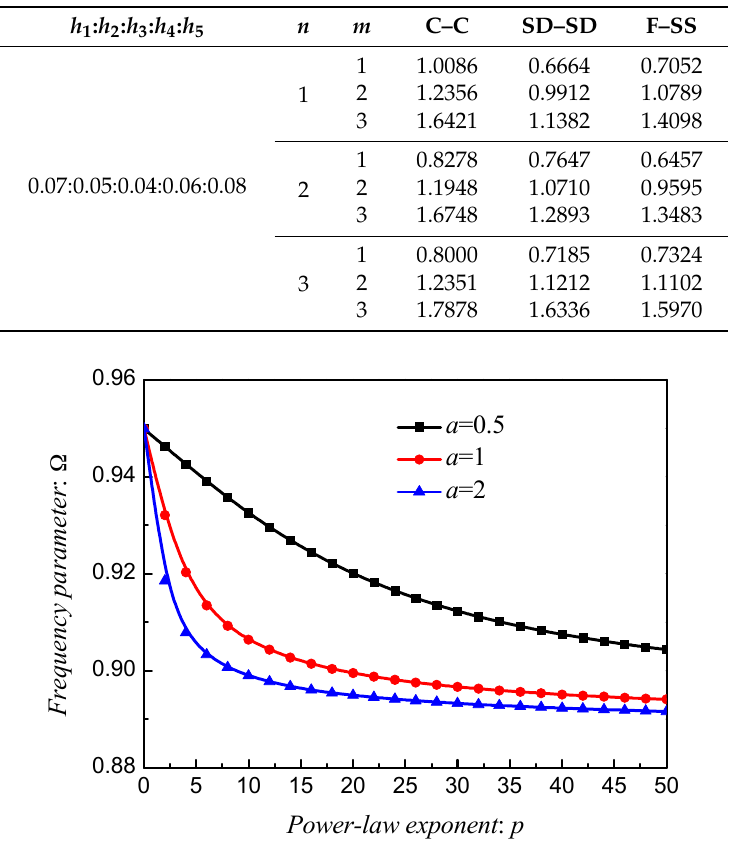
Figure 10. Results about different p and a of stepped FGM I ( a , b = 0.5; c = 2; p ) paraboloidal shell.